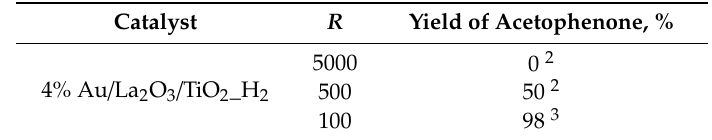
E ff ect of alcohol / Au ratio ( R ) on aerobic oxidation of 1-phenylethanol 1 with 4% Au / La 2 O 3 / TiO 2 _H 2